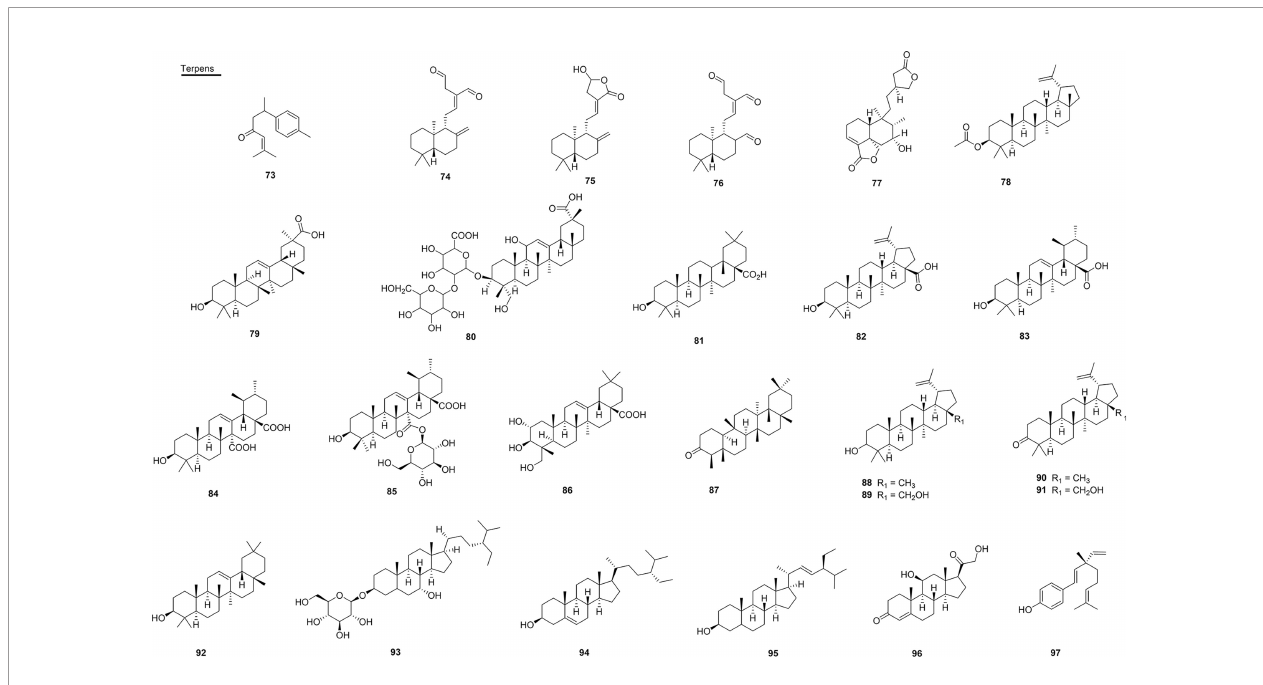
FIGURE 8 | Chemical structures of snakebite treatment compounds 73-97